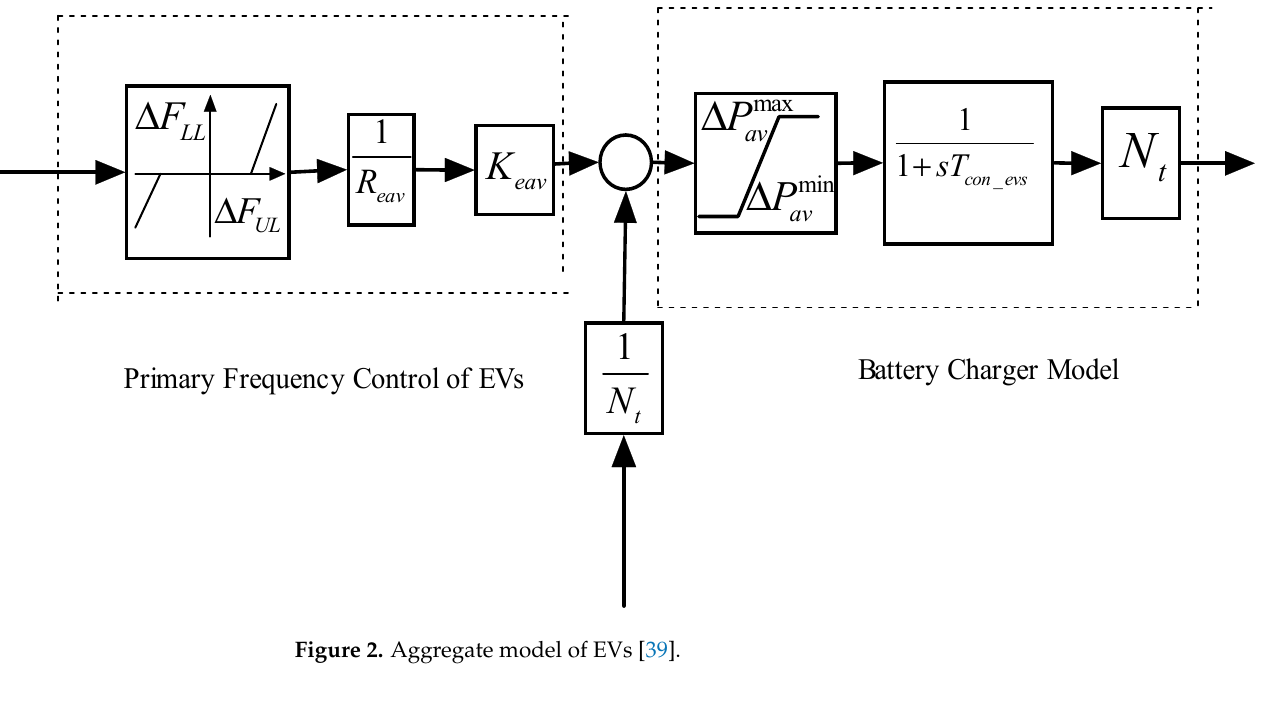
Figure 2. Aggregate model of EVs [39].